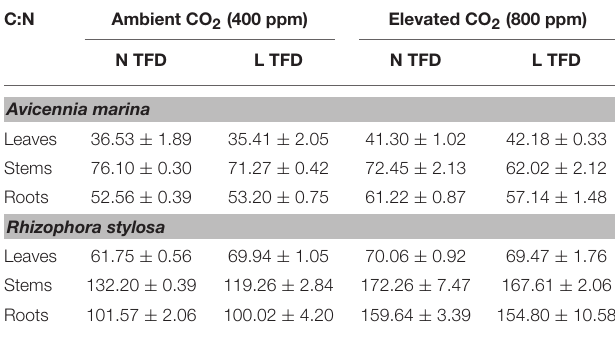
TABLE 2 | C:N ratios in leaves, stems and roots of A. marina and R. stylosa grown in ambient and elevated CO 2 , and under natural (N) and longer (L) TFD, for 12